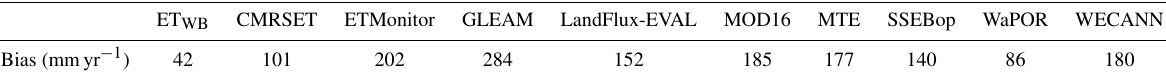
Table 8. Bias between the ET Budyko and, ET WB and ET RS .